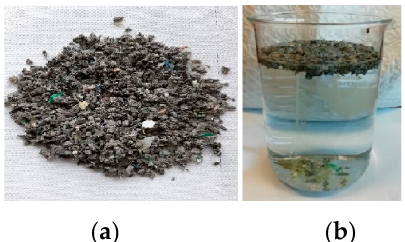
Figure 1. Feedstock before ( a ) and after ( b ) density separation in